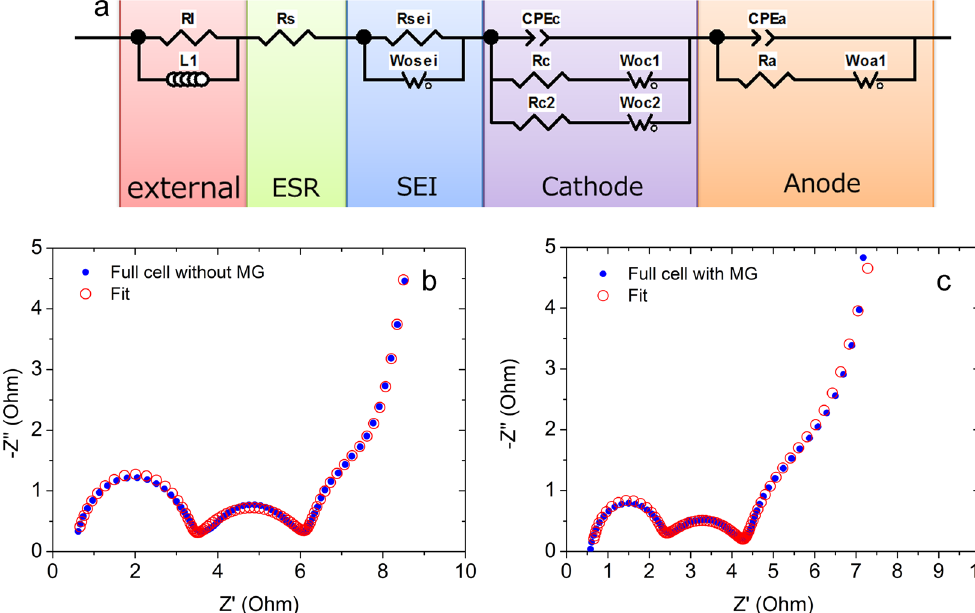
Figure 11. Electrochemical impedance spectroscopy (EIS) analysis: ( a ) equivalent circuit ( b ) EIS curve of cell without MG, and ( c ) EIS curve of cell with